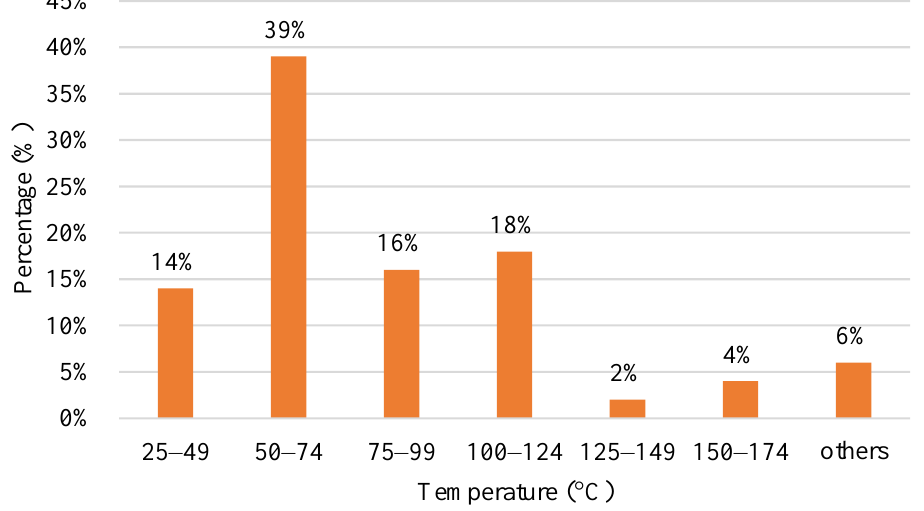
Figure 9. The range for bed temperature used in the FDM process for various material.